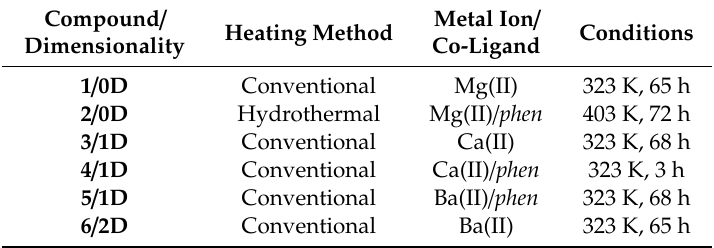
Table 1. Conditions of the synthetic protocols used in the preparation of diverse materials using H 2 aip and alkaline earth metals.